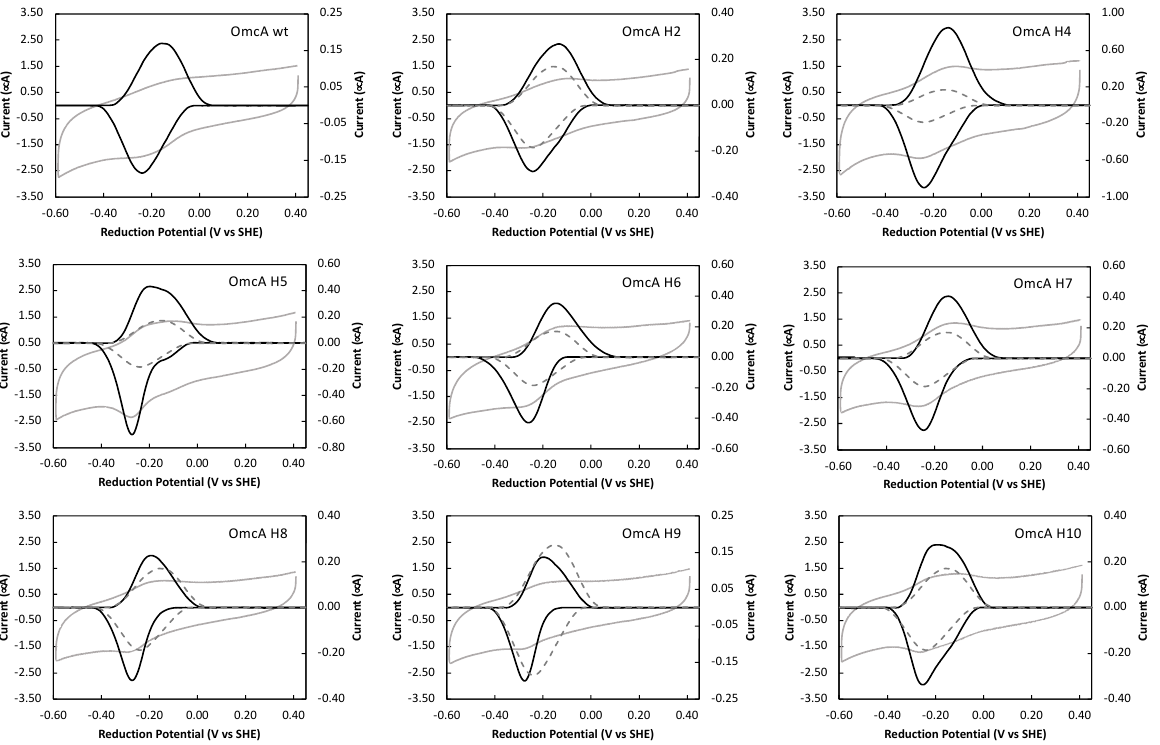
Figure 2. Cyclic voltammetry of native OmcA and eight mutants. In each panel, raw (grey and left axis) and capacitive current subtracted (black and right axis) voltammograms of each OmcA protein (native and mutant) obtained at a scan rate of 100 mV/s are presented. For comparison, the capacitive current-subtracted voltammogram of native OmcA is represented in the panels of the OmcA mutants as dashed line.